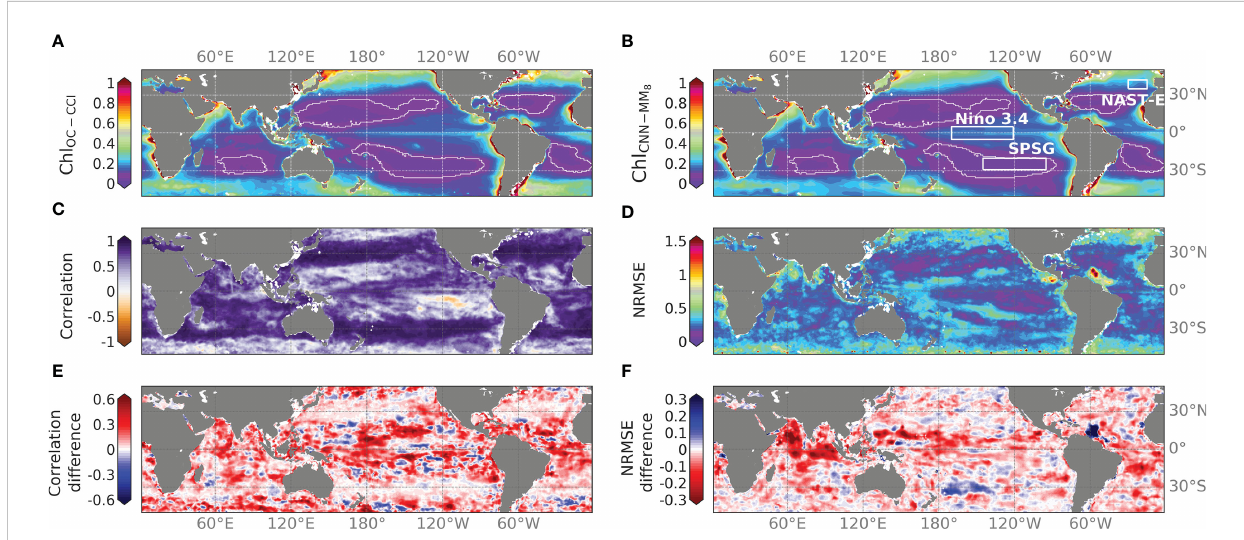
FIGURE 5 Time averaged (A) Chl OC-CCI and (B) CNN MM8 (in mg.m -3 ) over [2012-2015]. Oligotrophic gyre boundaries are delimited by the 0.07 mg.m -3 mean Chl isocontour superposed in white. (C) Correlation and (D) NRMSE of Chl OC-CCI vs. CNN MM8 over the same time-period. (E) Correlation and (F) NRMSE differences between CNN MM8 and Chl CNN1 over the same time period. NB: the colorbar is reversed for the NRMSE difference when compared to the correlation difference to highlight in red where the Chl reconstruction with CNN MM8 is